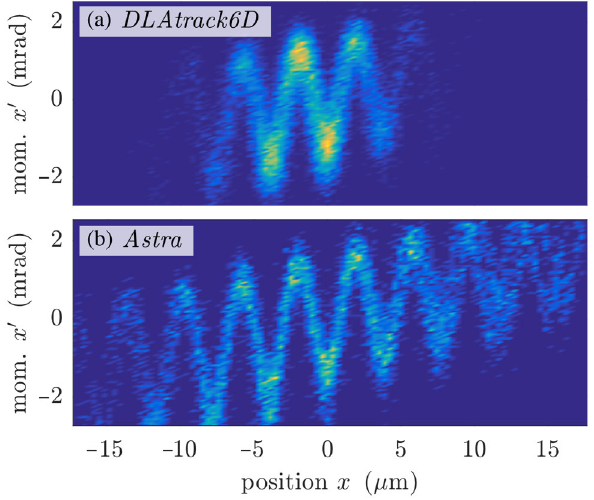
FIG. 15. Comparison of horizontal phase space from DLA- track6 D and ASTRA at z ≈ 9 . 3 mm in the asynchronous DLA 546 μ m. undulator lattice for λ und ¼